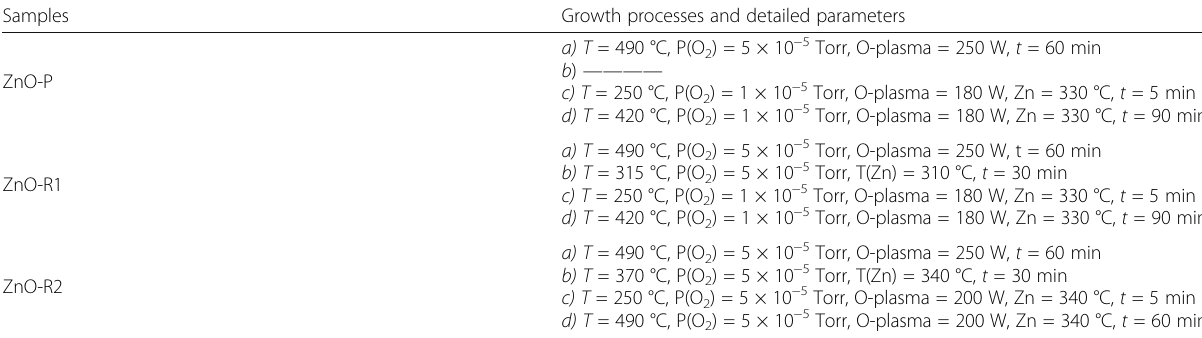
Table 1 Detailed growth conditions for the ZnO films Samples Growth processes and detailed